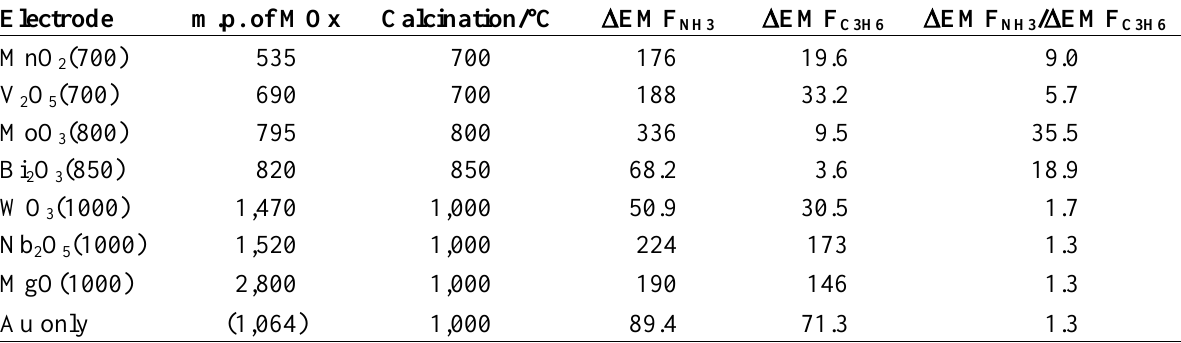
Table 1. Summary of  EMF to 500 ppm of NH electrode covered with mixtures of Au and various metal